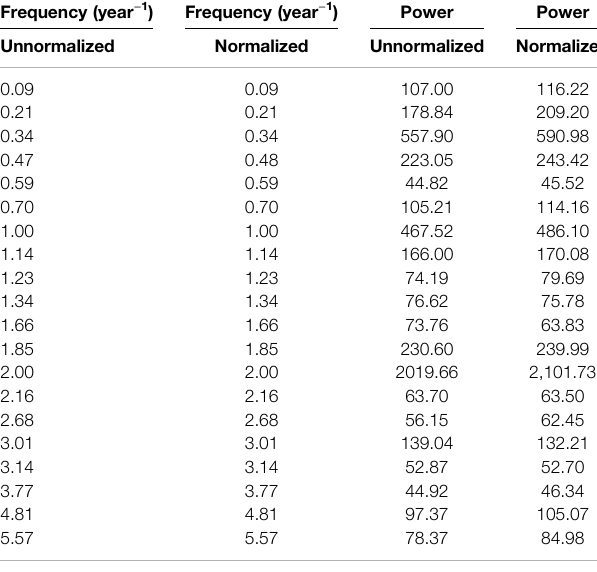
TABLE 2| Thefrequencyand power ofthe top20peaks inpower spectraformed from nighttime data for the frequency range 0 – 6 year − 1 , as computed from unnormalized data and from rono-normalized data.